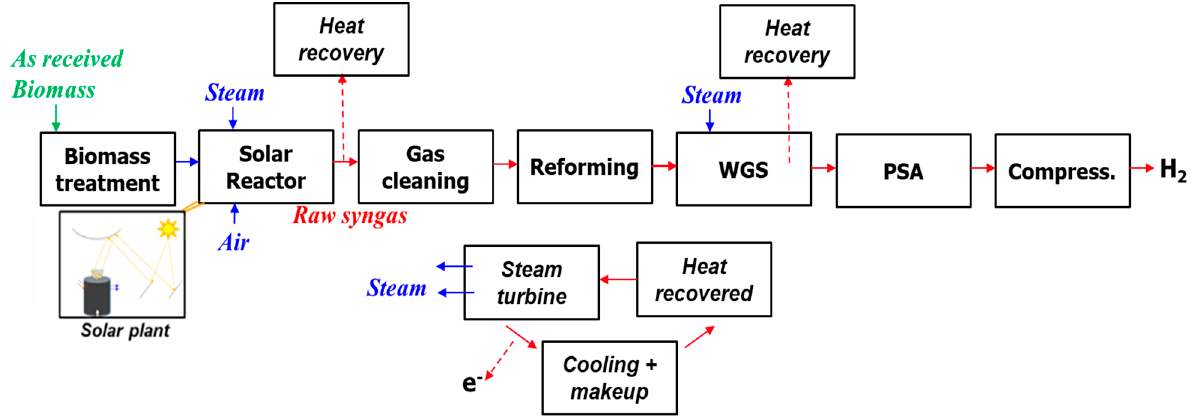
Figure 1. Biomass solar gasification flow diagram.